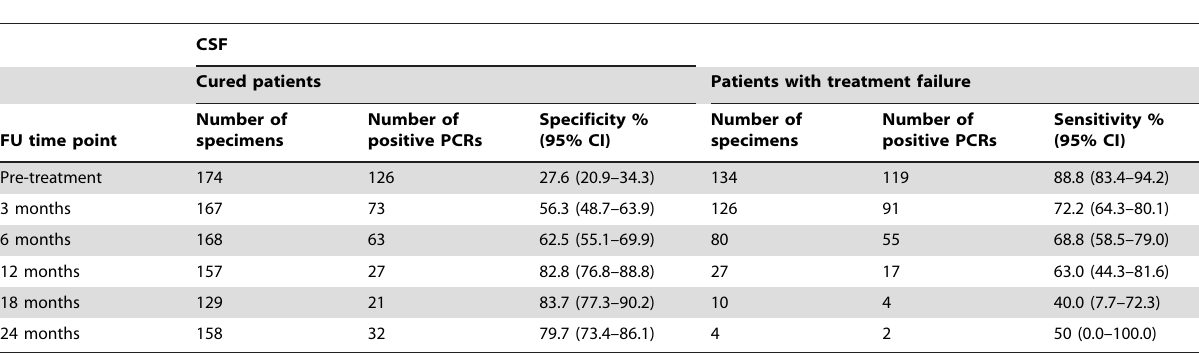
Table 4. Specificity and sensitivity of PCR on CSF during post-treatment follow-up.